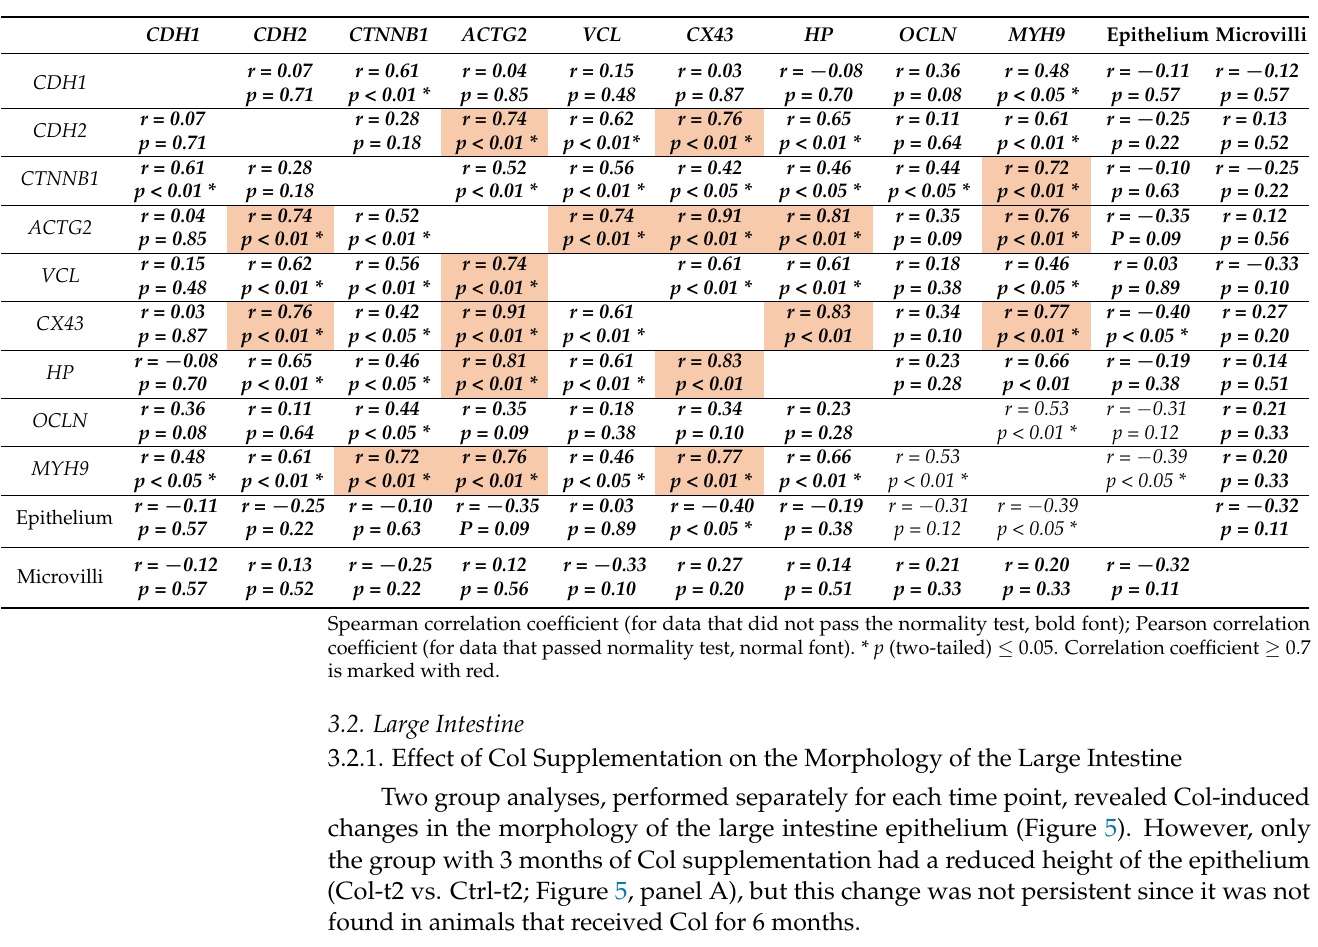
Table 1. Results of a simple correlation between CDH1 , CDH2 , CTNNB 1, CX43 , VCL , OCLN , HP , and ACTG2 , and the epithelium and microvilli thickness in the small intestine.